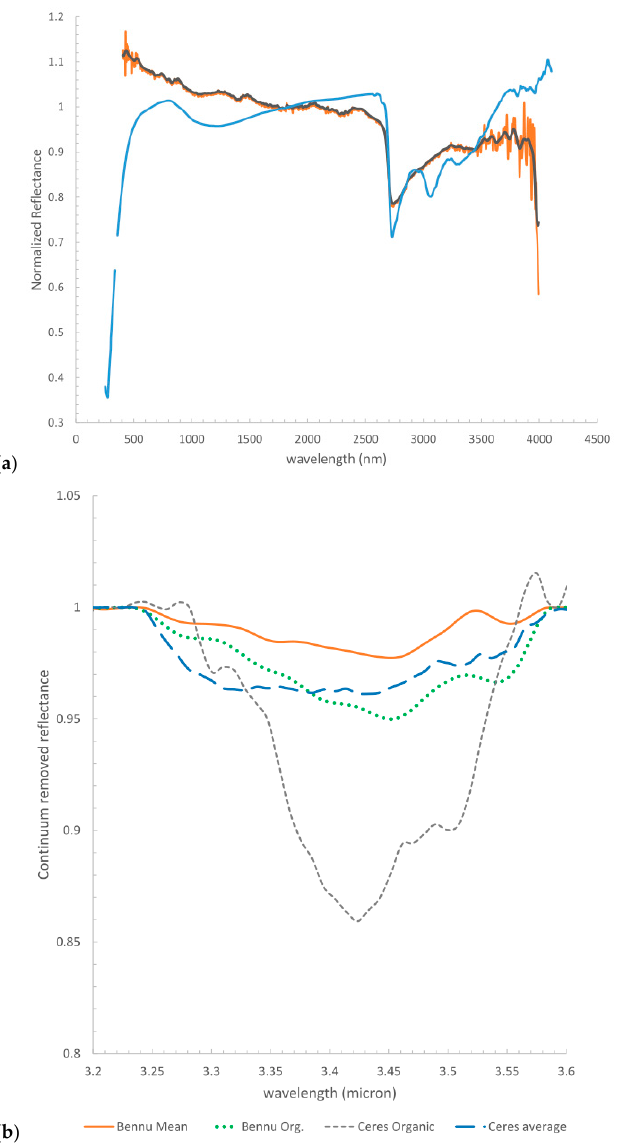
Figure 3. ( a ) Comparison between the average spectrum of Ceres (blue) and Bennu (not smoothed data in orange; smoothed data in grey). The spectra have been normalized at 2000 nm. Bennu spectra are from [55], Ceres spectrum from [24]. ( b ) Comparison between Ceres (blue ‐ average spectrum, gray organic ‐ rich average spectrum) and Bennu (average in orange; organic ‐ rich in green). The spectra have been removed by the continuum in the range 3.25–3.6 μ m. Bennu spectra are from [52,55]. Ceres spectra from [15,24].